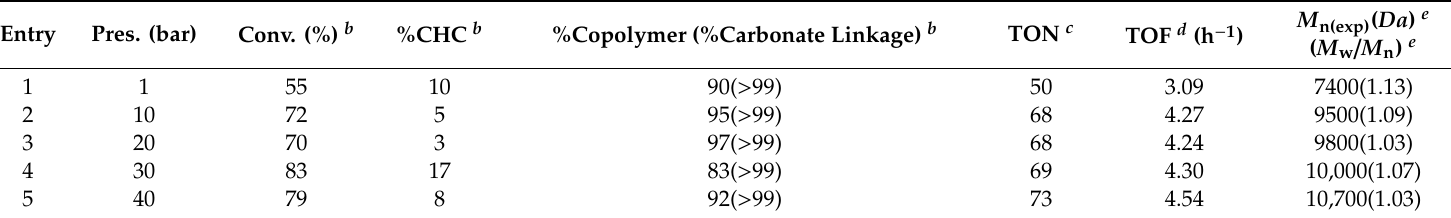
Table 4. E ff ect of reaction pressure on the synthesis of poly(cyclohexene carbonate) catalysed by complex 4 a